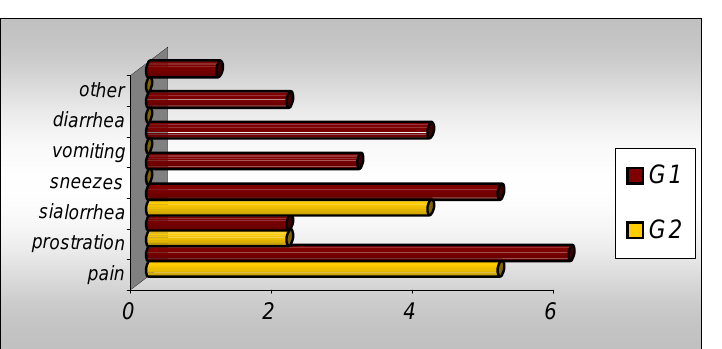
Figure 1: Clinical signs observed in the six animals of each group studied (G1 = 0.25 mg/kg and G2 = 0.4 mg/animal) at T1 (1h after envenomation). Botucatu, São Paulo, Brazil, 2003 .